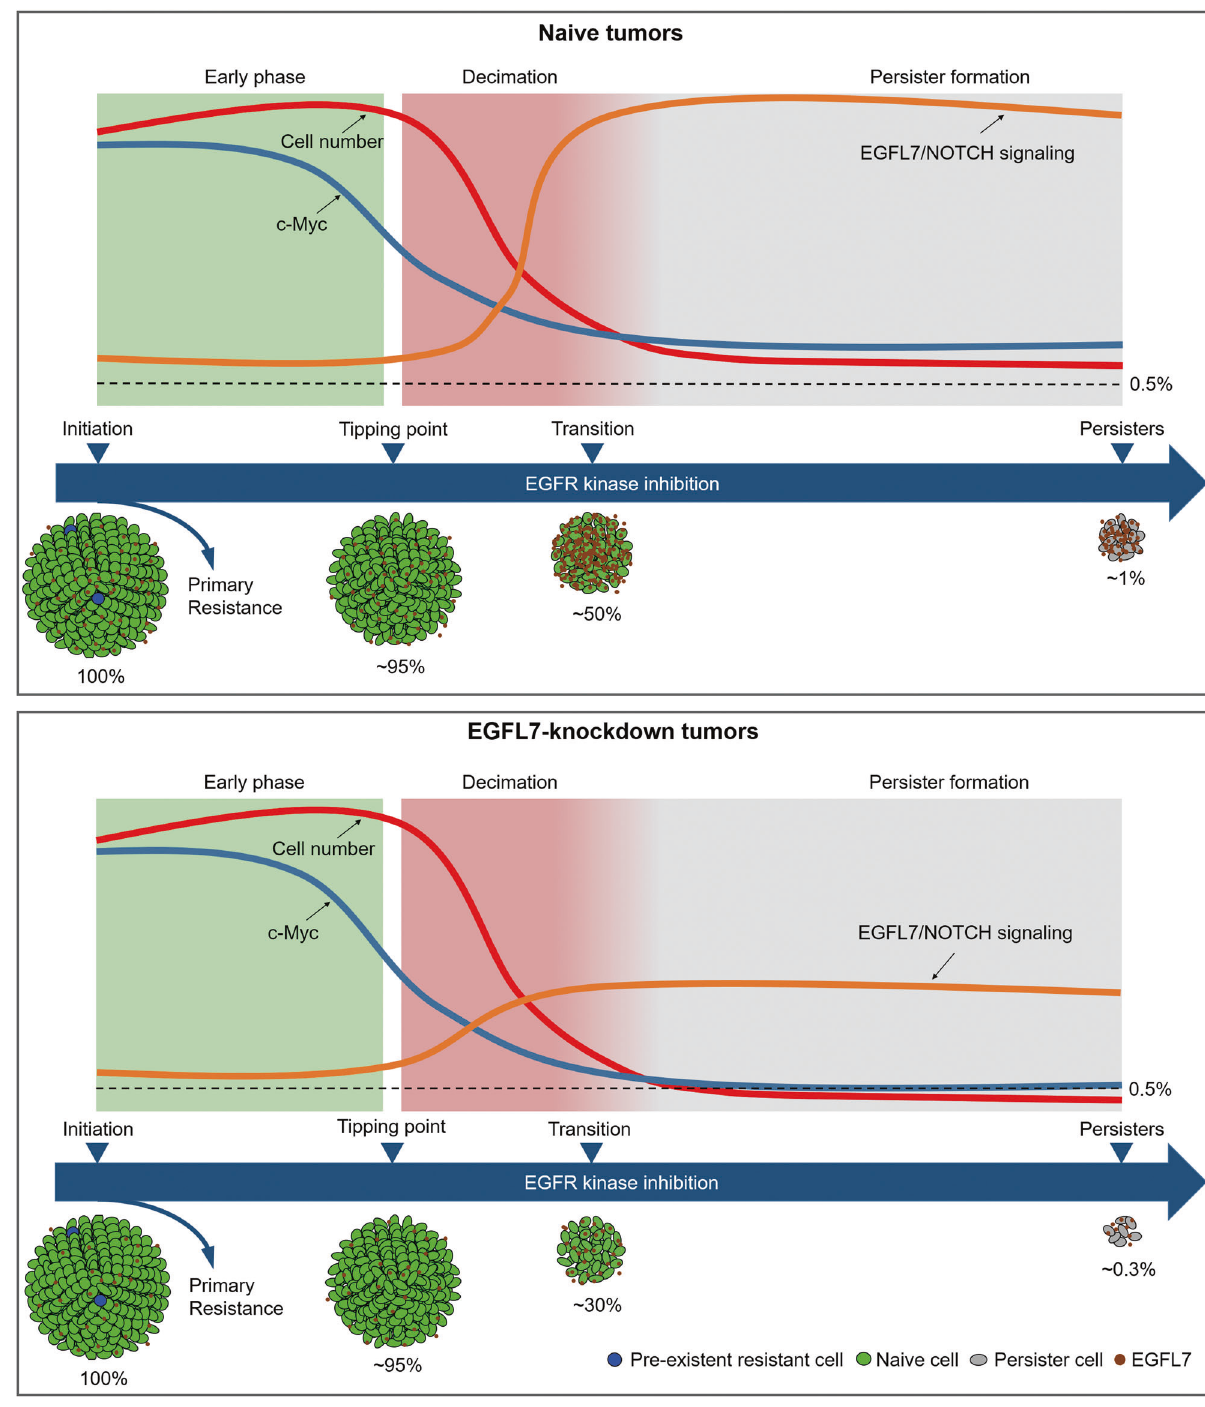
Fig. 8 A model for the transition from sensitive cells to persister cells during EGFR kinase inhibition. The cartoon depicts dynamic process as EGFR kinase inhibition elongates. Phenotypically, cells fi rst remain nearly normal then experience rapid number decline and fi nally a small fraction transform into persister cells. Accordingly, the activity of EGFL7/NOTCH signaling is low in the fi rst stage, increasing during the decimation phase and maintain high since then, decelerating the decline of c-Myc and ultimately contributing to the formation persister cells. Knockdown of EGFL7 largely disturbs this process and results in a lower fraction of persister